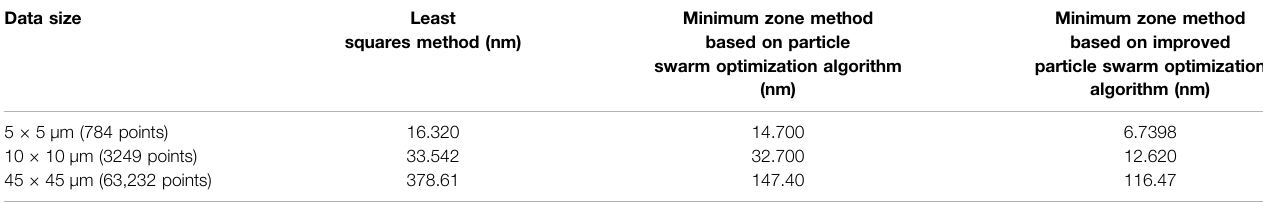
For the surface topography data of leveled SHS samples of 5 × 5 μ m, the class A standard uncertainty values of the fl atness error evaluation results of the three algorithms are shown in Table 3 . For the surface topography data of leveled SHS samples of 10 × 10 μ m, the class A standard uncertainty values of the fl atness error evaluation results of the three algorithms are shown in Table 4 . It can be seen from Tables 3 and 4 that, in the fl atness error evaluation results of leveled SHS sample surface topography of 5 × 5 μ m and 10 × 10 μ m, the evaluation uncertainty of the minimum area method based on the improved PSO algorithm is far less than that of the standard least squares method and standard PSO algorithm. The experimental results show that the fl atness error evaluation result of the minimum zone method